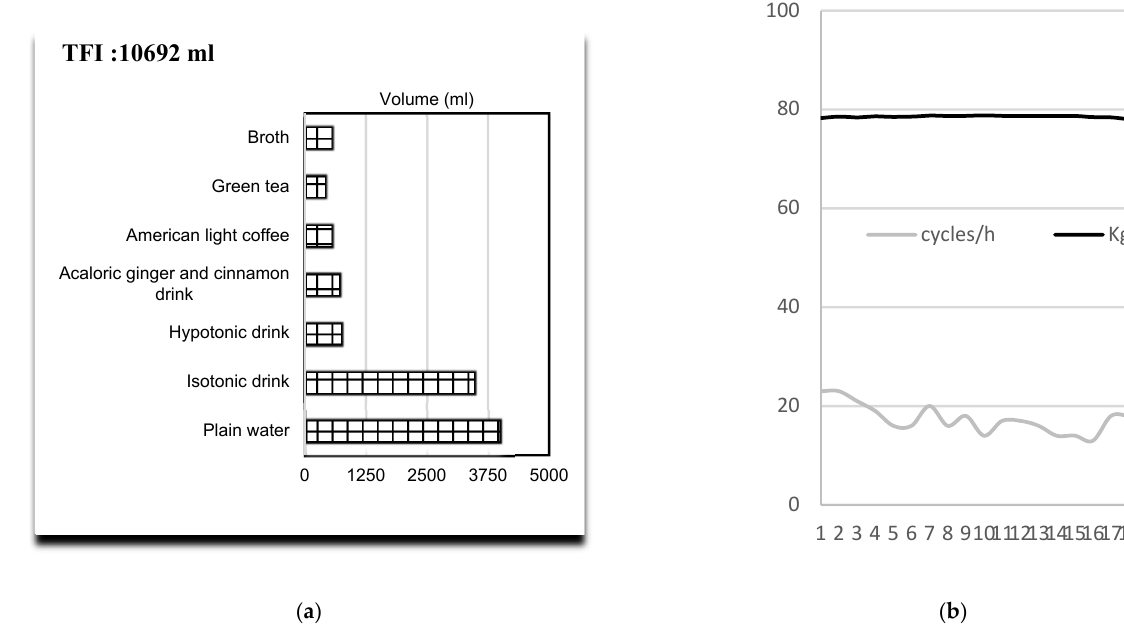
Figure 2. ( a ) Volume intake (mL) and percentage of contribution to the total fluid intake (TFI). ( b ) Bodyweight (kg) and number of cycles completed during the 18 h event .